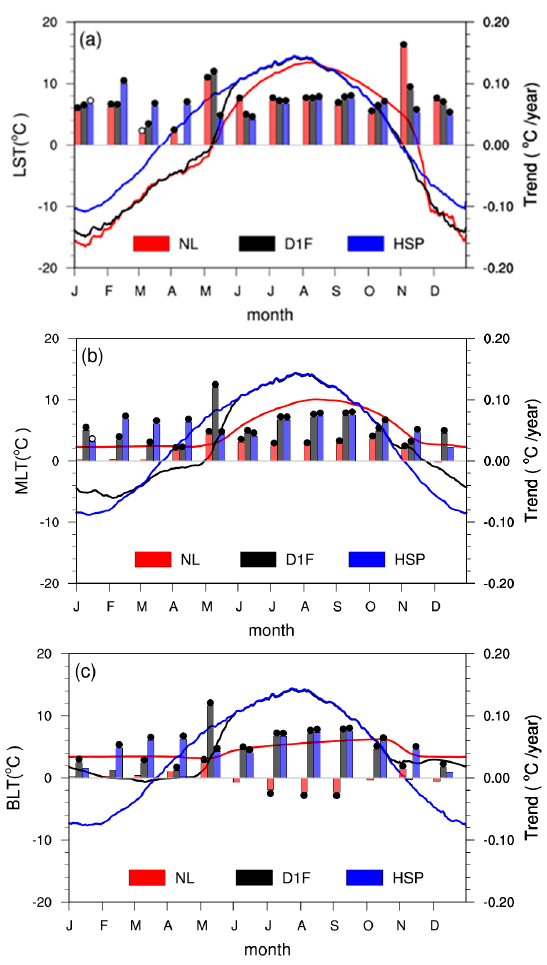
Figure 5. The monthly mean temperatures (°C, lines) and their long-term trends (°C/year, bars) in the model runs S-NL (red), S-HSP (blue) and S-D1F (black). Panels ( a – c ) correspond to LSWT, MLT and BLT, respectively. Solid and hollow points at the end of bars mean passing the significance test of p < 0.01 and p < 0.05, respectively.